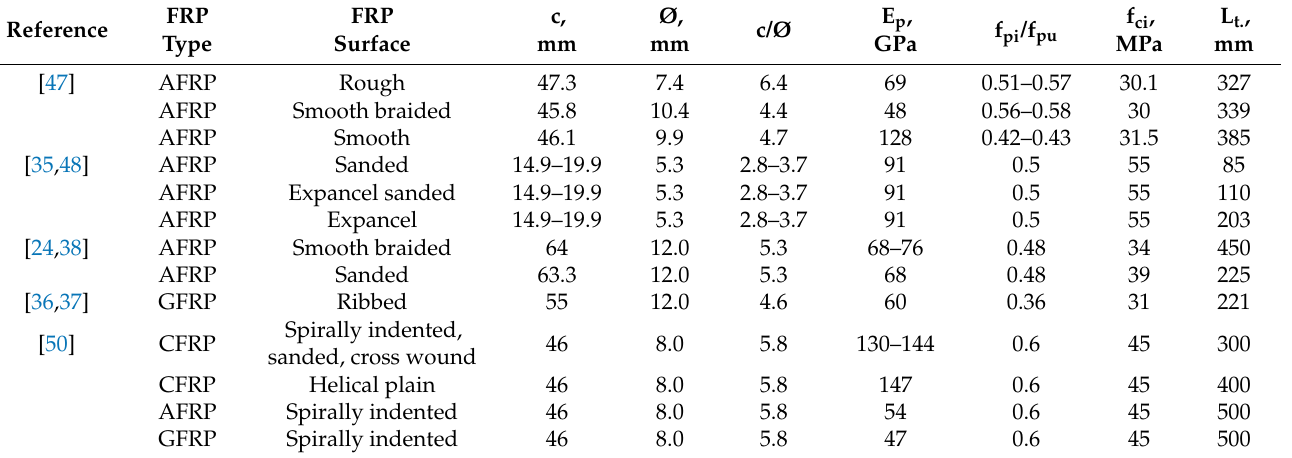
Table 6. Summary of transfer length results on the influence of reinforcement surface